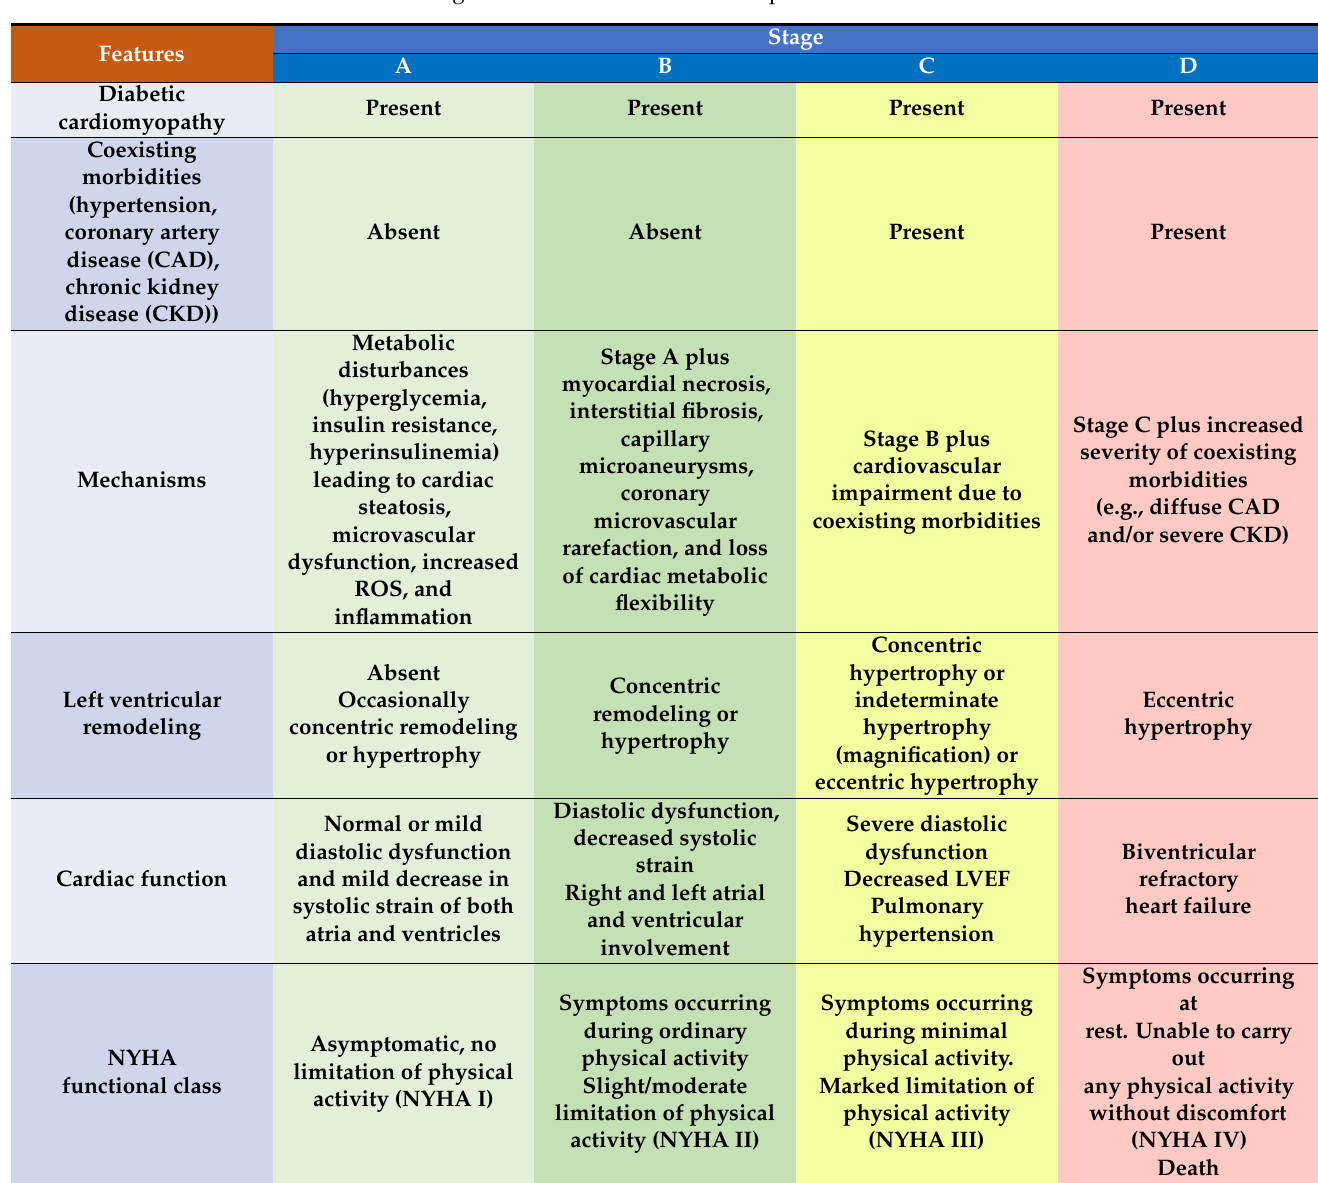
Table 1. Stages of newonset heart failure in patients with